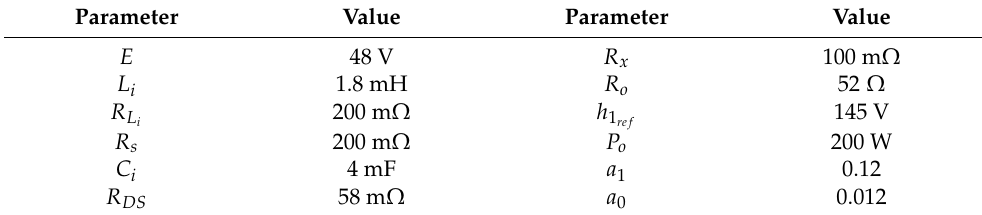
Table 1. Parameters of the